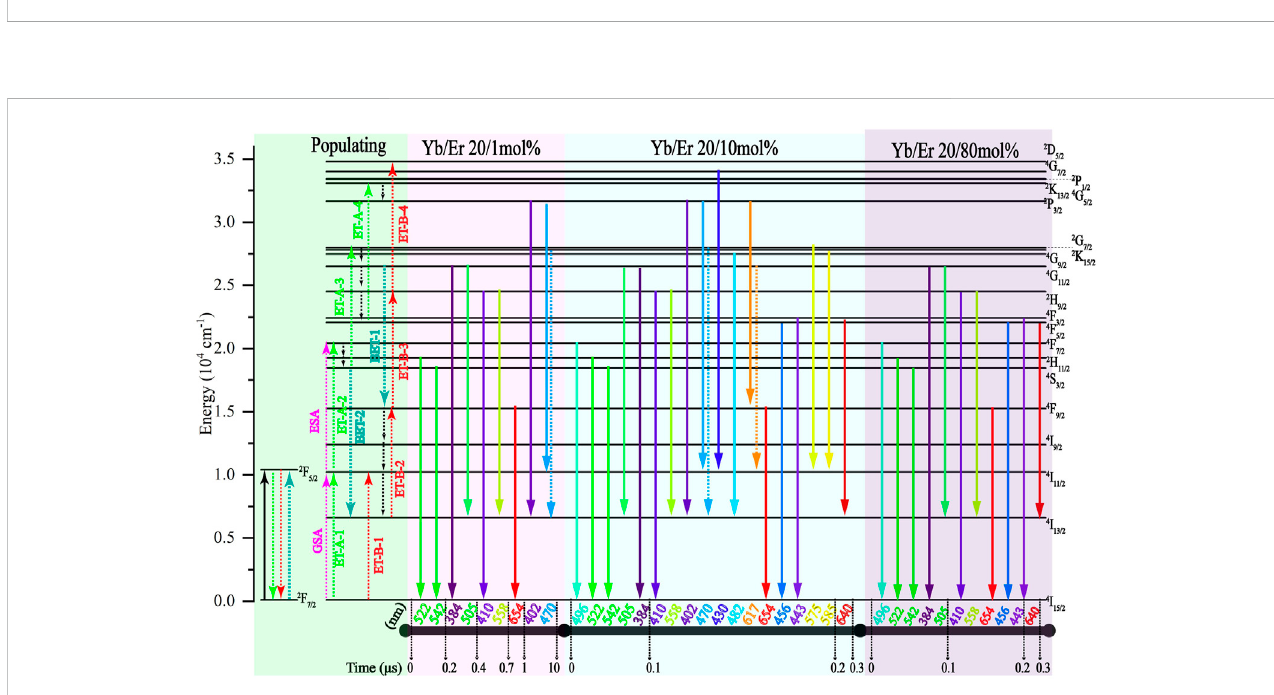
FIGURE 3 NaYF 4 :Yb 3+ /Er 3+ evolutionspectrumofYb 3+ /Er 3+ (20/xmol%)under976 nmpulseexcitation. (A,B) x =1, (C) x =10,and (D) x =80.The976 nm ns-pulsed excitation starts from the 0 moment.